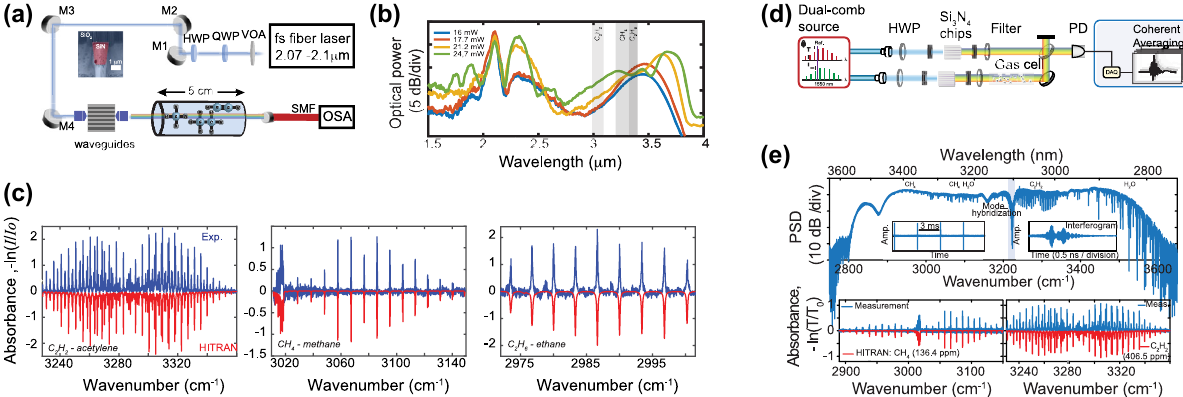
Figure 19: Spectroscopy applications of on-chip SCG. (a) Experimental setup for absorption spectroscopy. (b) Experimental SCG generation in a SiN waveguide pumped at 2.1 μ m and different pump powers. (c) Normalized experimental gas absorbance (blue) and the HITRAN database (red) for H , CH , and C H . (d) Schematic of dual-comb setup where the two combs are generated in SiN waveguides. (e) Retrieved MIR spectrum from the C 2 2 4 2 6 detected and coherent averaged (52 s) interferogram trace. (g) Measured gas absorbance (blue), CH the HITRAN database. Panels (a)–(c) adapted from [201], panels (d) and (e) adapted from